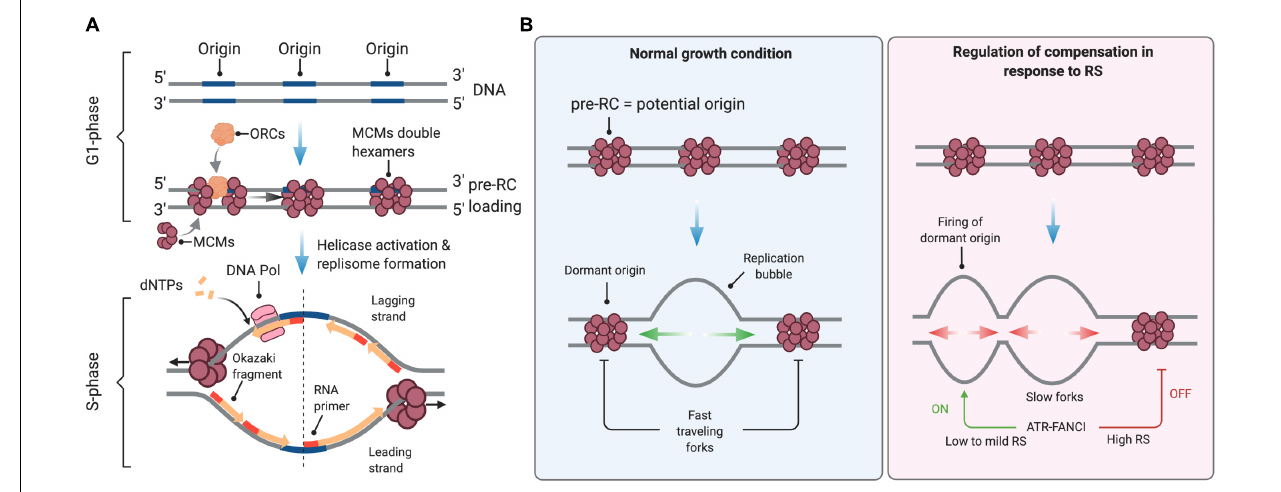
FIGURE 1 | Control of DNA replication origin firing. (A) Origins of replication are licensed during the G1 phase of the cell cycle through the sequential loading of the ORC and MCM complexes to form the pre-replication (pre-RC) complex. At the S-phase onset, S-CDK and DDK activate the replicative helicase by recruiting CDC45 and the GINS complex, enabling DNA unwinding and the formation of active replisomes. dNTPs are the essential building blocks used by the replicative DNA polymerases to elongate nascent DNA. (B) In normal growth conditions, firing is limited to a few licensed origins. Forks travel at full speed, inactivating neighboring unfired origins. Under conditions of low to mild RS, cells compensate for slow elongation by activating backup origins known as dormant origins. Under acute RS conditions, the ATR-FANCI pathway restrains the activation of new origins. See the text for further details. This figure has been created with